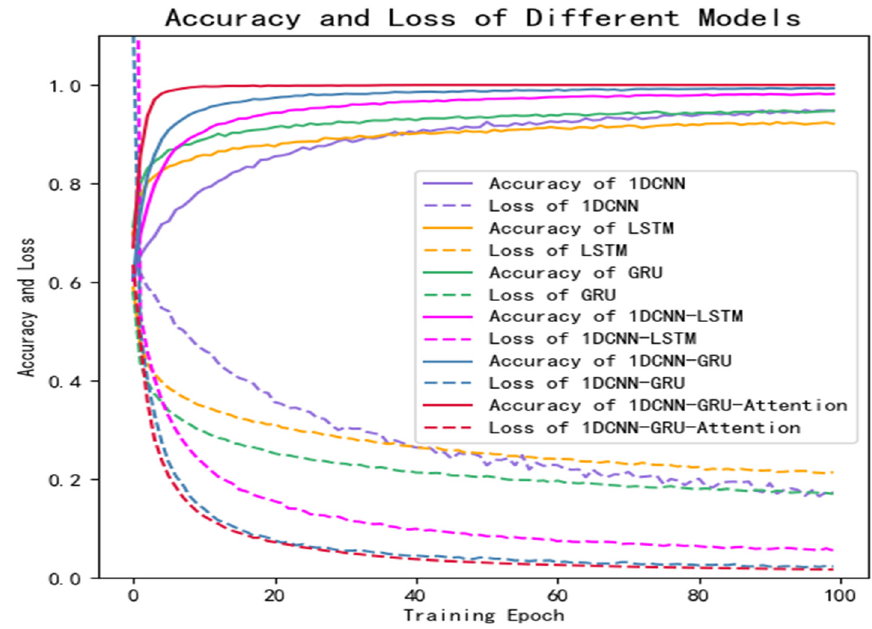
Figure 9. Results of comparative experiments on public dataset.